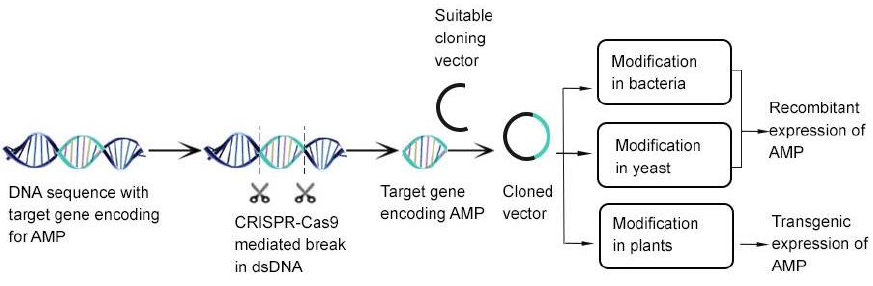
Figure 2. CRISPR-Cas 9 combination with existing gene-editing tools in the discovery of novel AMPS. Image adapted from [196] with some modifications.